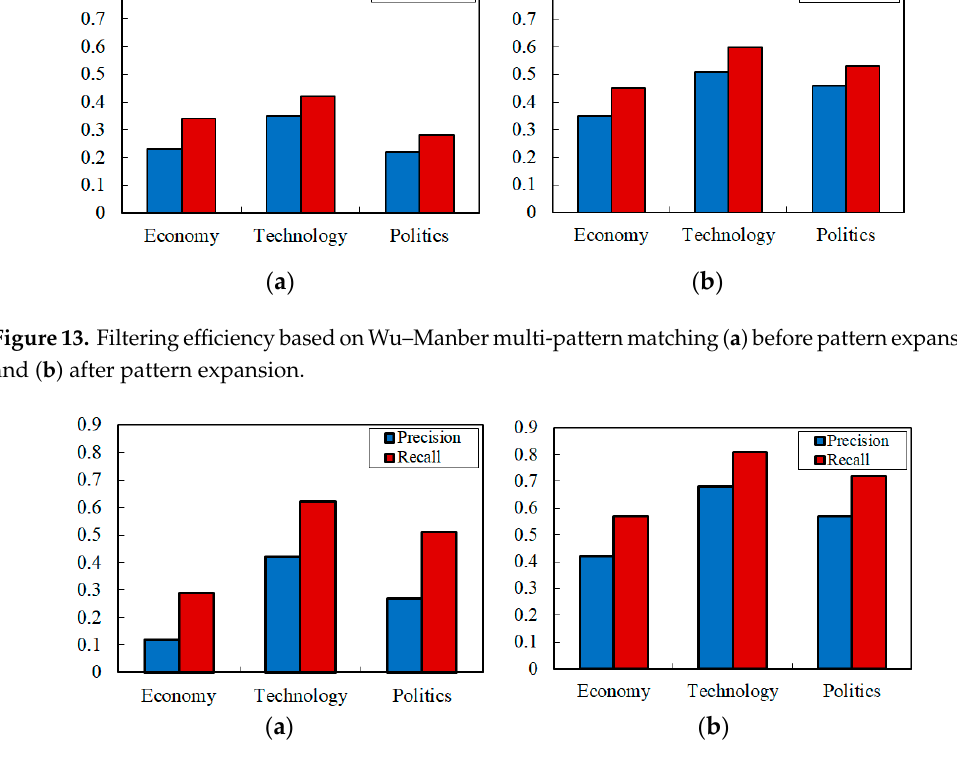
Figure 14. Filtering efficiency based on Wu–Manber–Uy multi-pattern matching ( a ) before pattern expansion and ( b ) after pattern expansion.